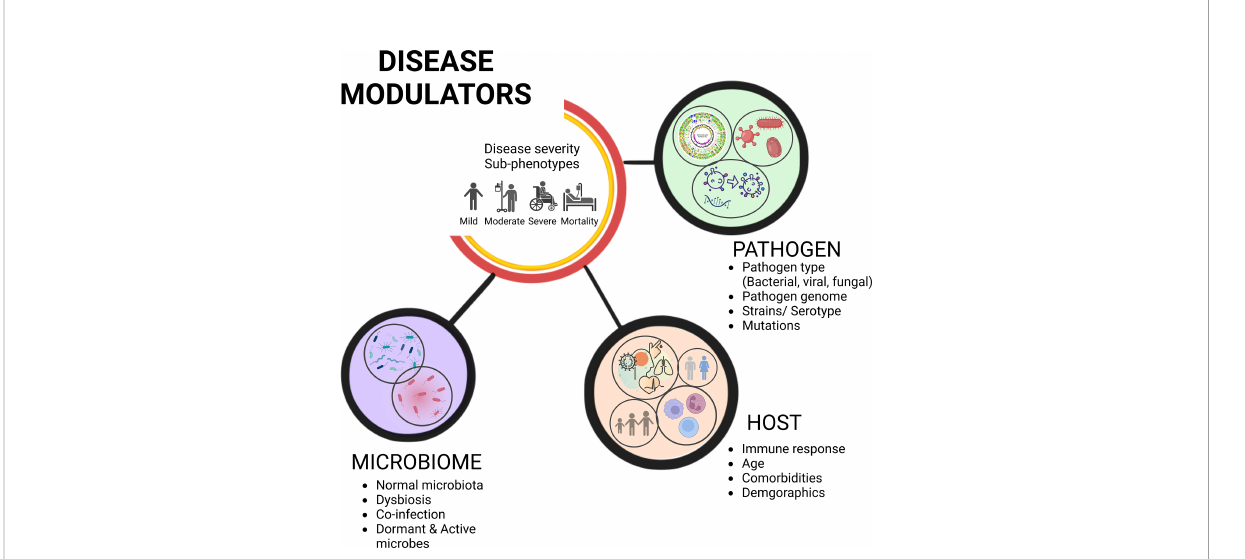
FIGURE 1 Disease severity sub-phenotypes, clinical outcome, and modulators. The complex yet intricately regulated interplay of variables governs disease severity sub-phenotypes and differential clinical outcome. Understanding pathogen and host responses integrally, along with the role of microbes, in fl uence the trajectories of disease progression and clinical